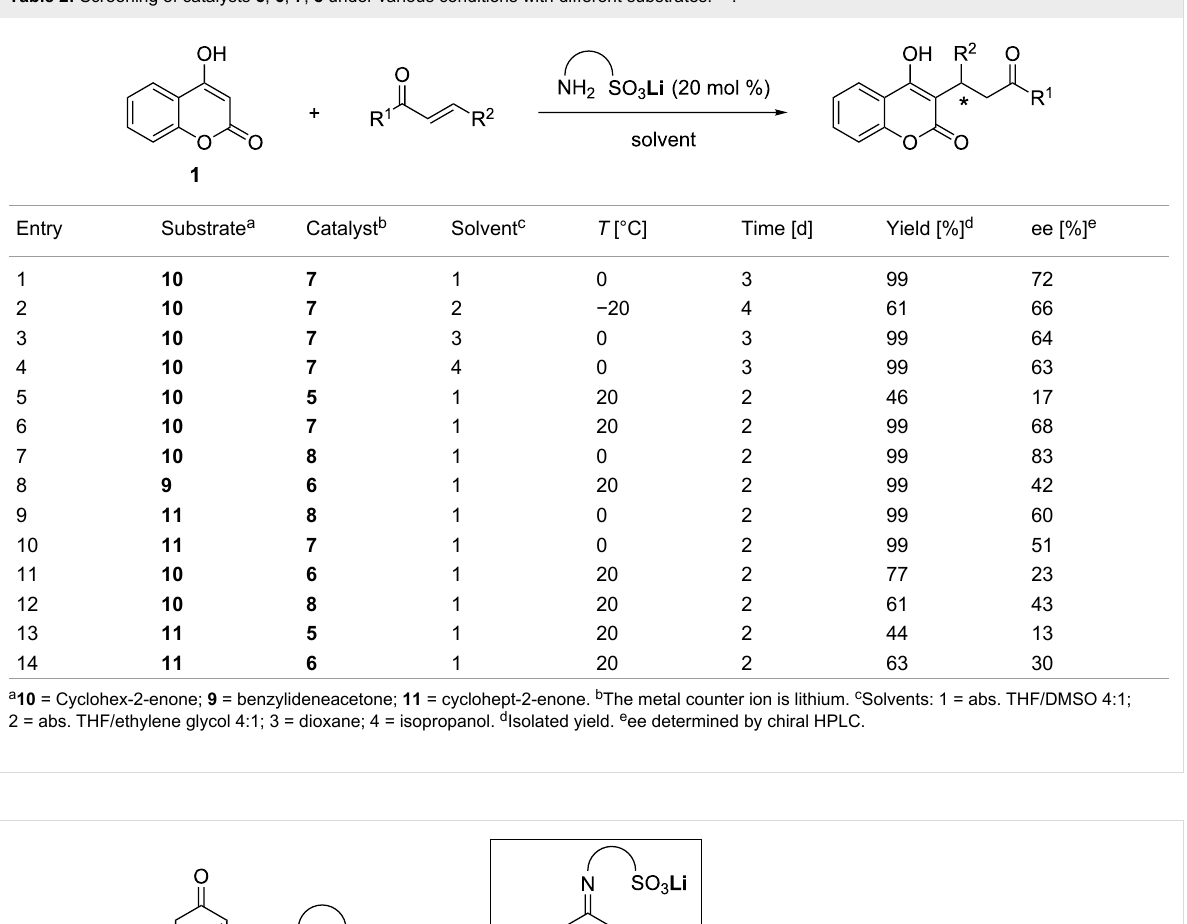
Table 2: Screening of catalysts 5 , 6 , 7 , 8 under various conditions with different substrates. a,b .